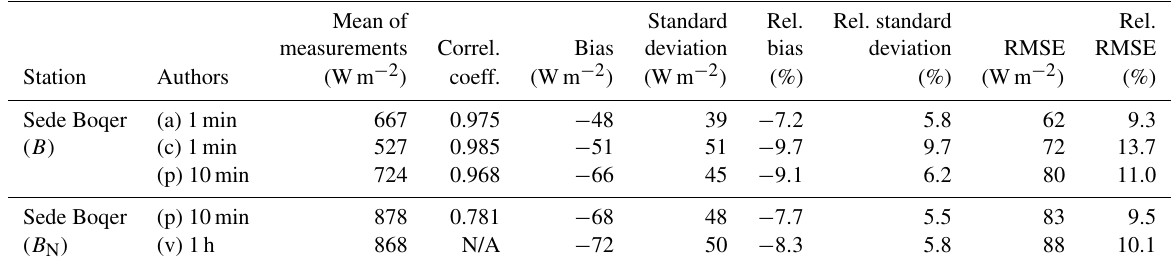
Table 16. Comparison of results obtained for B or B N at different summarizations at the same station. N/A: not available. Mean of Standard Rel. Rel. standard